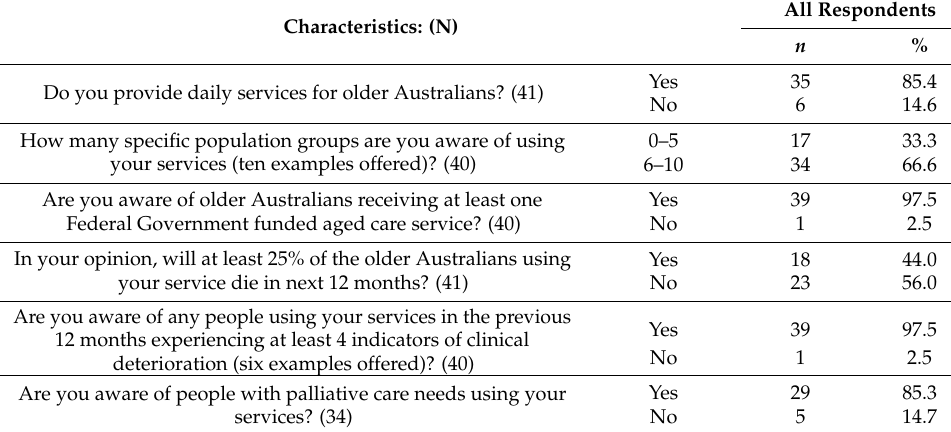
Table 3. Practice